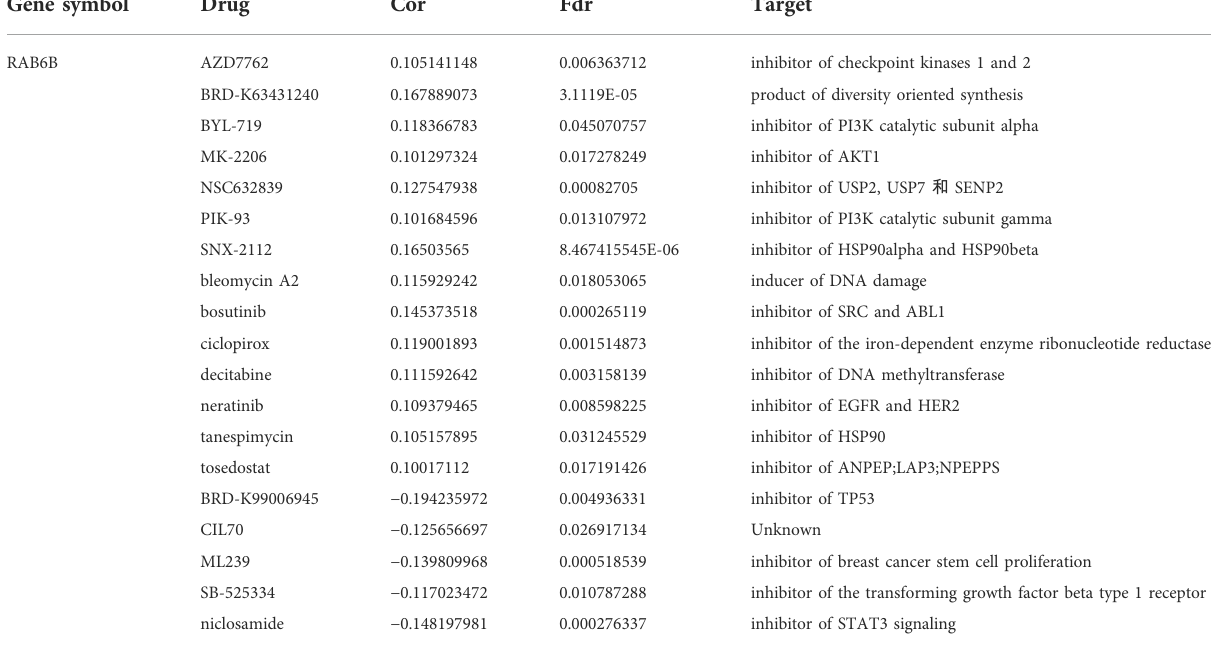
TABLE 6 Correlation between CTRP drug sensitivity and RAB6B mRNA expression. Gene